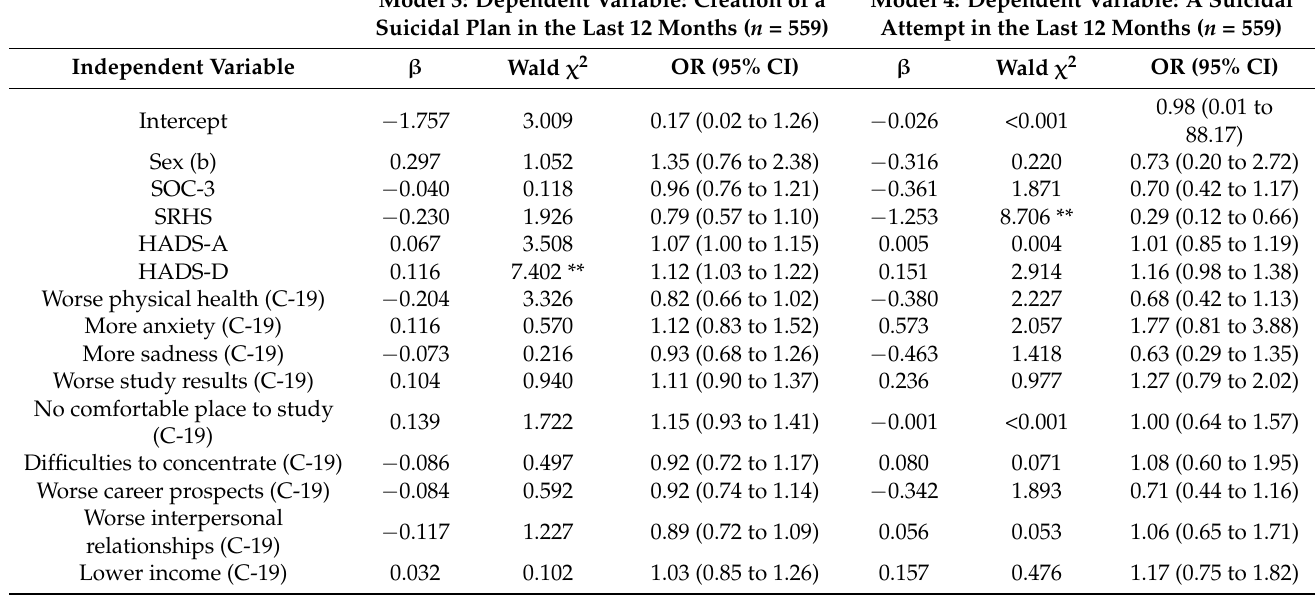
Table 4. Cont. Model 3: Dependent Variable: Creation of